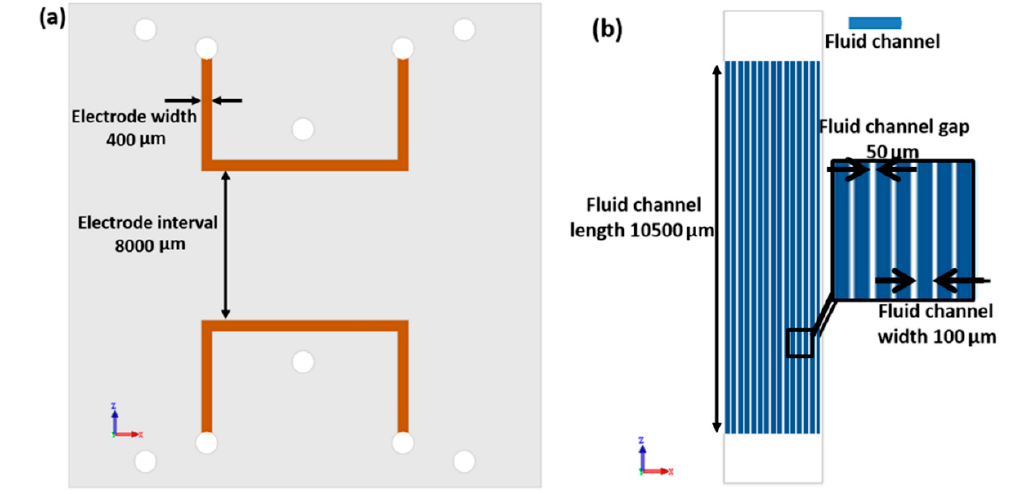
Figure 2. Schematic of the dimensions of EOF pump. ( a ) Electrode channel (top view) ( b) fluid channel (top view).